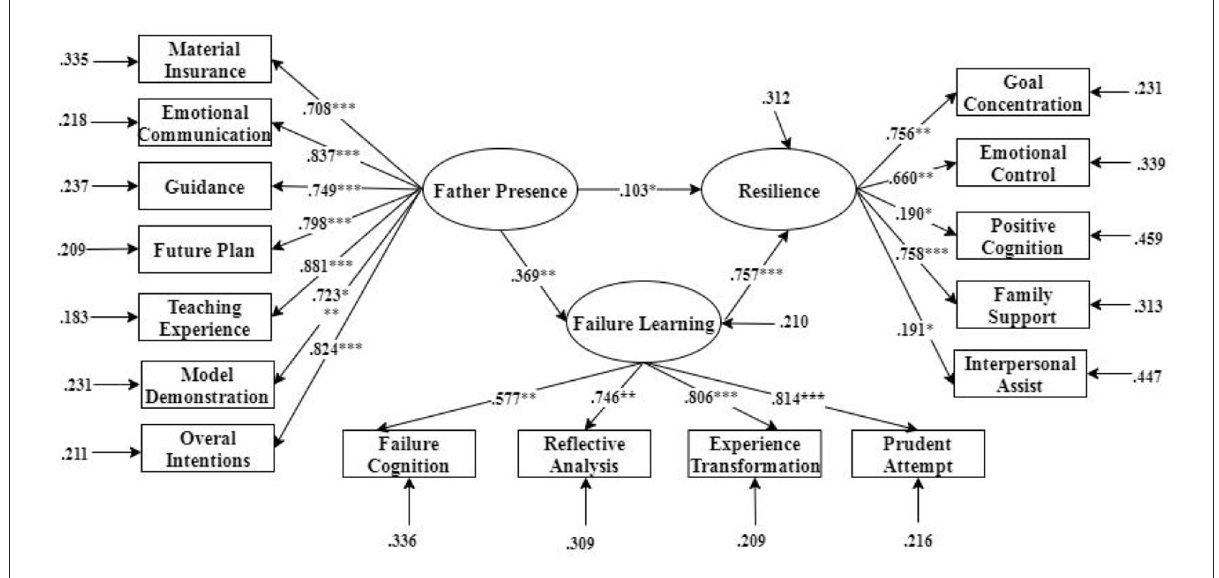
FIGURE3 Mediating model of learning failure between father presence and resilience. * p < 0.05; ** p < 0.01; *** p < 0.001.